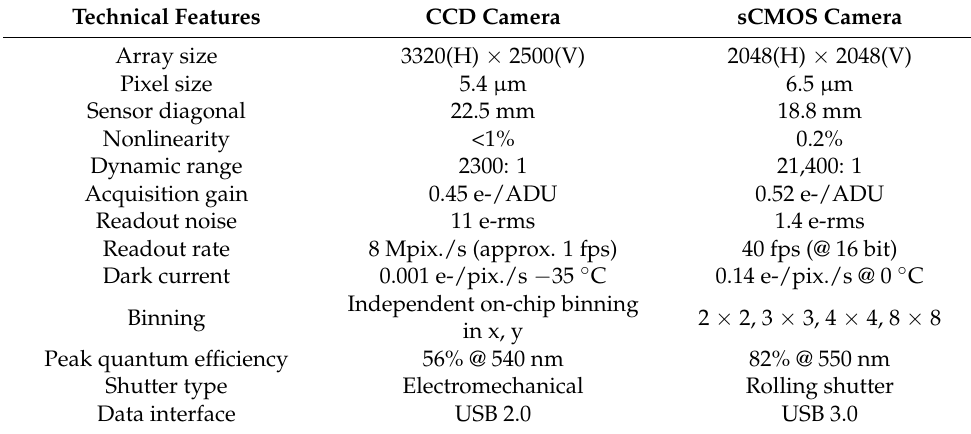
Table A2. Nominal parameters of both used cameras without a lens